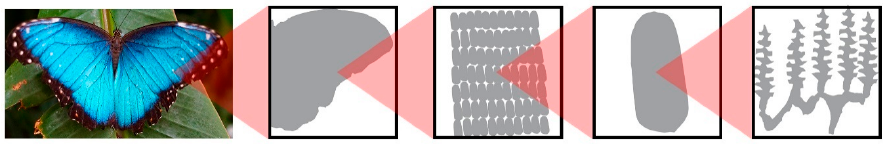
Figure 8. From left to right: Morpho Menelaus , its wings, micro-scaled structures forming a pattern over the wings, a single scale of Morpho Menelaus and a scale showing a few ridges giving color. Photo by Damon On Road on Unsplash.